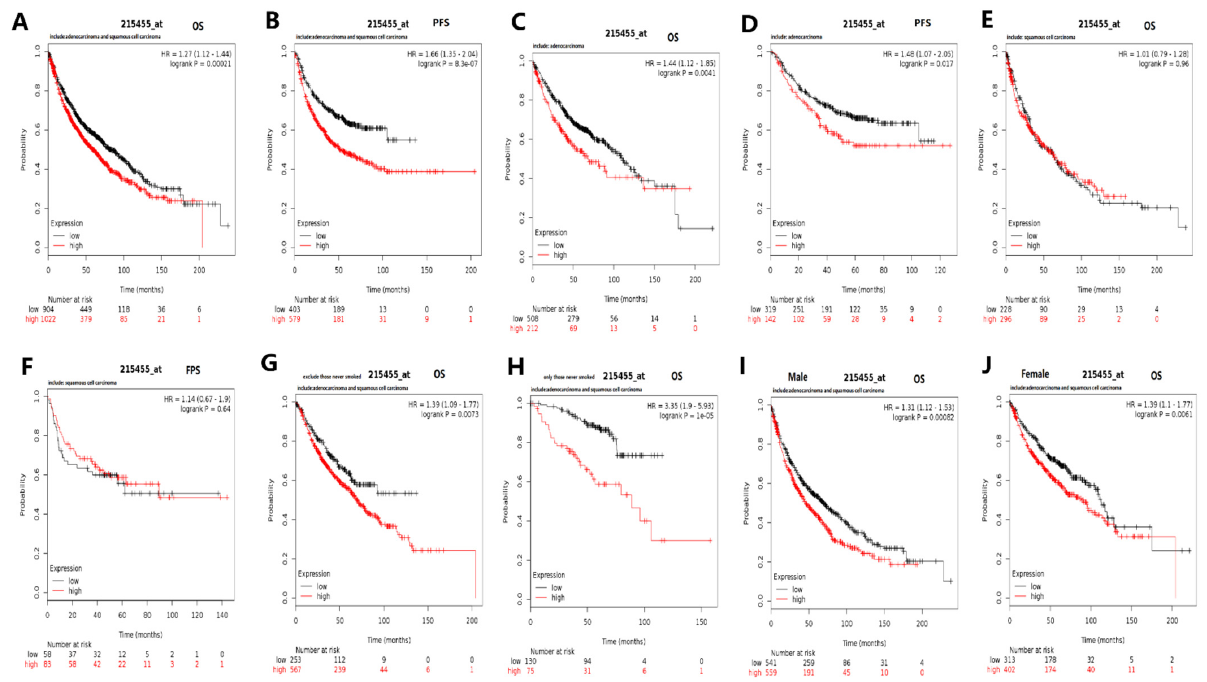
Figure 5. Prognostic potential of the Timeless gene in patients with lung cancer analyzed using Kaplan–Meier plotter. High expression of the Timeless gene was associated with ( A , C ) poor OS and ( B , D ) poor PFS of patients with lung squamous cell carcinoma and lung adenocarcinoma. ( G , H ) Timeless gene expression was of prognostic value for patients with lung cancer irrespective of their smoking habits. ( I , J ) High expression of the Timeless gene was associated with poor OS of both males and females. ( E , F ) Timeless gene expression was associated with poor OS and PFS of patients with lung squamous cell carcinoma, while it was not associated with those of patients with lung squamous cell carcinoma. PFS, progression ‐ free survival; OS, overall survival; HR, hazard ratio (presented with 95% CI).